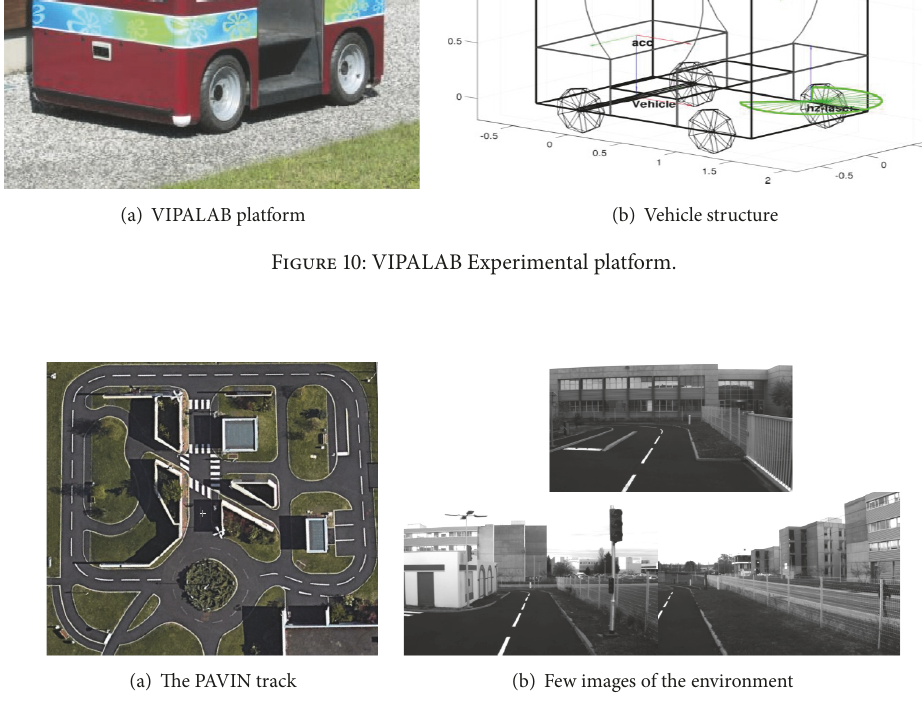
Figure 11: Institute Pascal Experimental